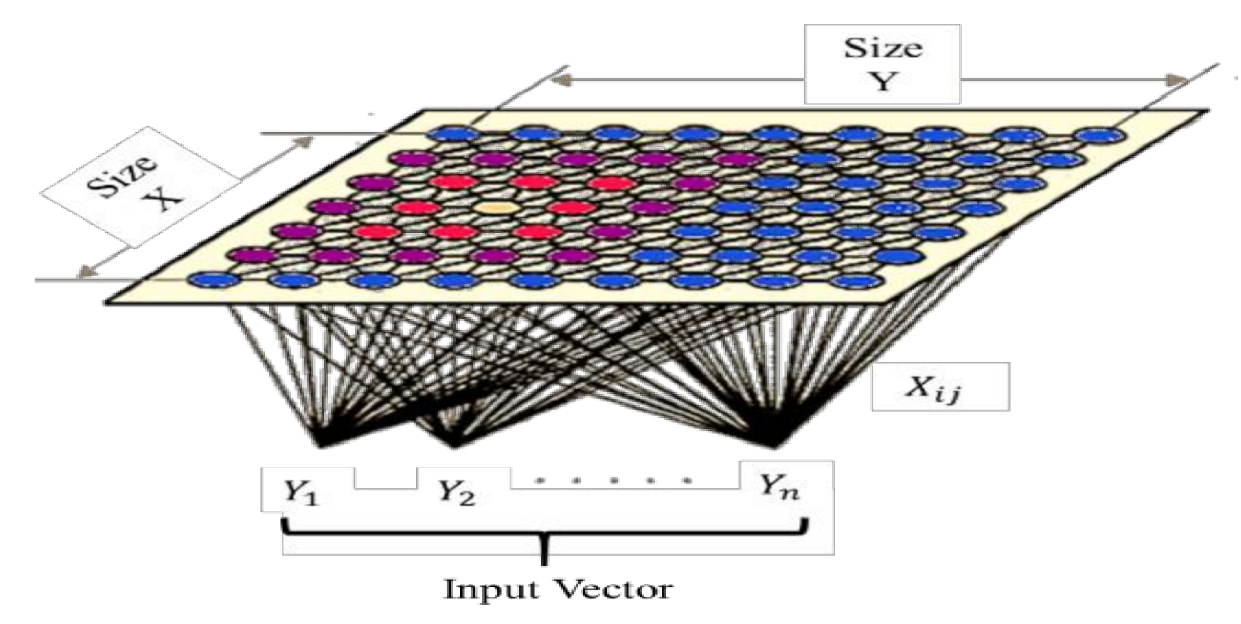
Figure 4. Structural representation of a self-organizing map.